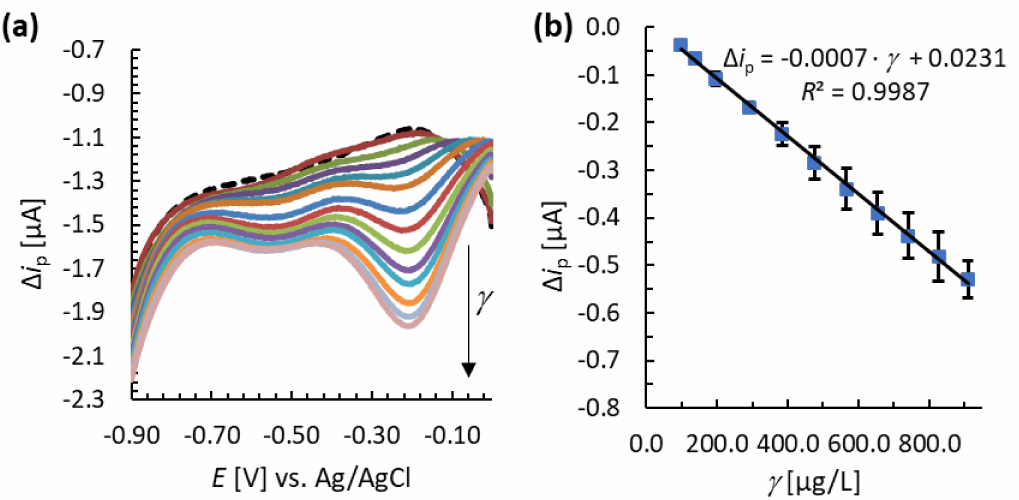
Figure 2. ( a ) Cathodic SW voltammograms measured with ex-situ BiFE in 0.1 M acetate buffer containing 99.0–909.1 µ g/L Cr(VI) (measurement of the blank is shown with dashed line) and ( b ) the corresponding linear calibration curve ( γ represents the mass concentration in µ g/L and error bars denote standard deviation of replicate